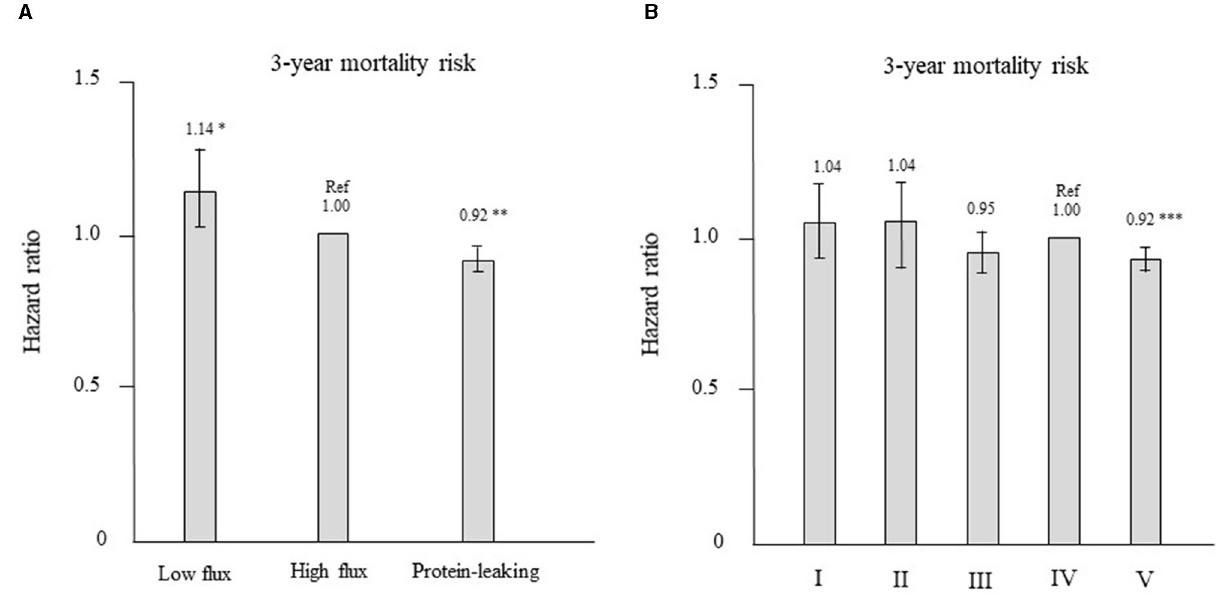
both classified as protein-leaking membrane dialyzers, this study indicated the superiority of type V dialyzers. Randomized controlled studies are warranted to determine whether